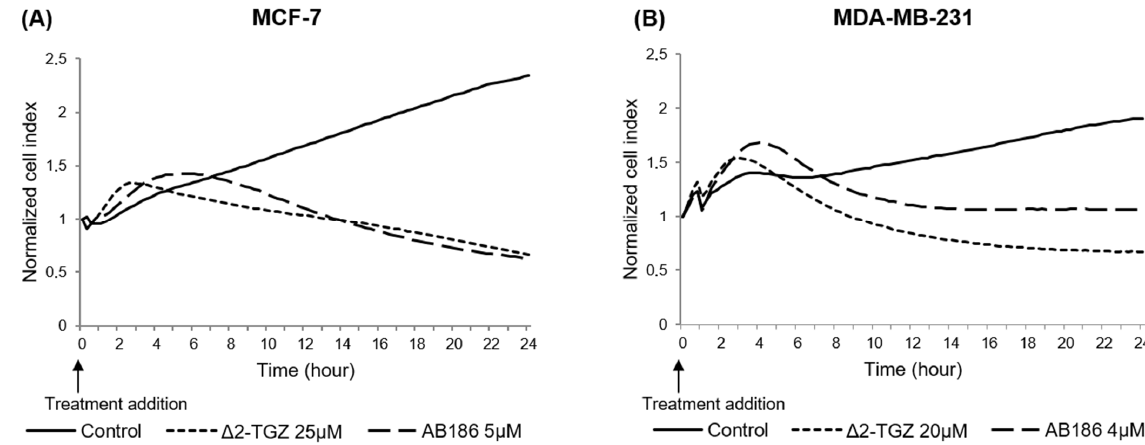
Figure 3. Kinetics of real-time impedance changes in response to TGZ derivatives in MDA-MB-231 and MCF-7 cells. ( A ) MCF-7 and ( B ) MDA-MB-231 cells were grown during 29 h and then were exposed (treatment addition) to Δ 2-TGZ (25 µM and 20 µM respectively) or AB186 (5 µM and 4 µM respectively). Control cells were treated with DMSO. Cell index was monitored during 24 h after treatment addition. Reported data are the means of three independent experiments.